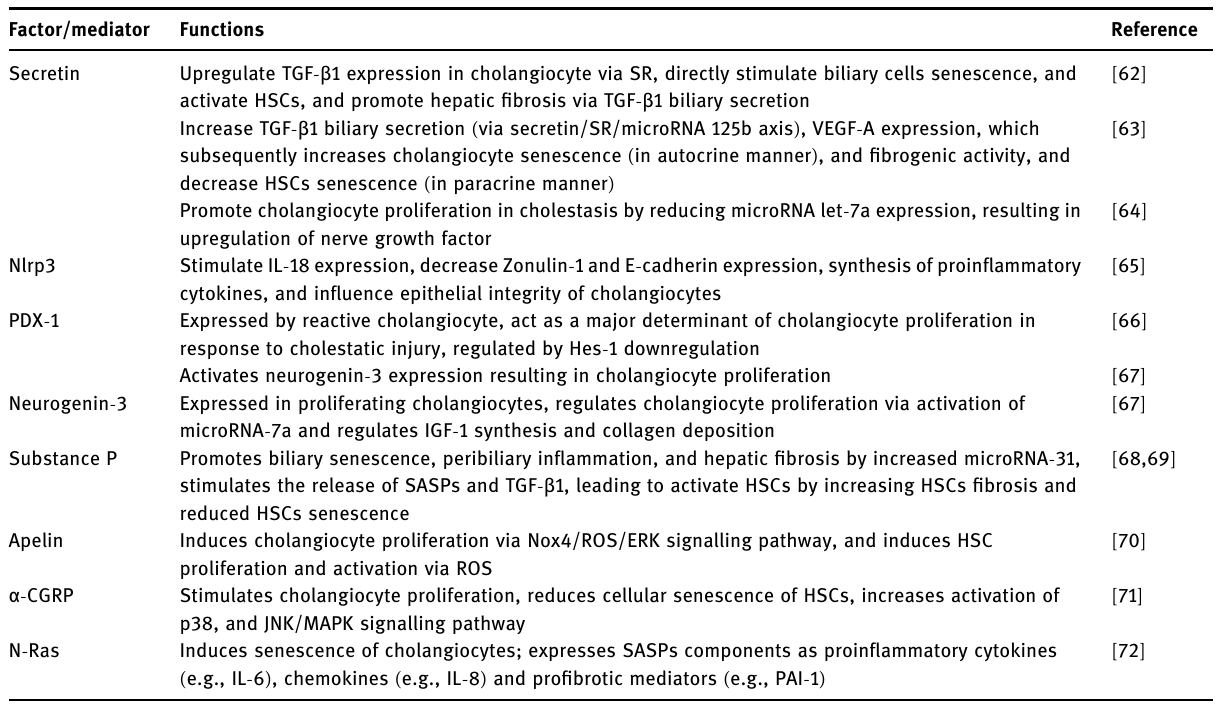
Table 2: Summarising the expressed factors involved in cholangiocyte in PSC